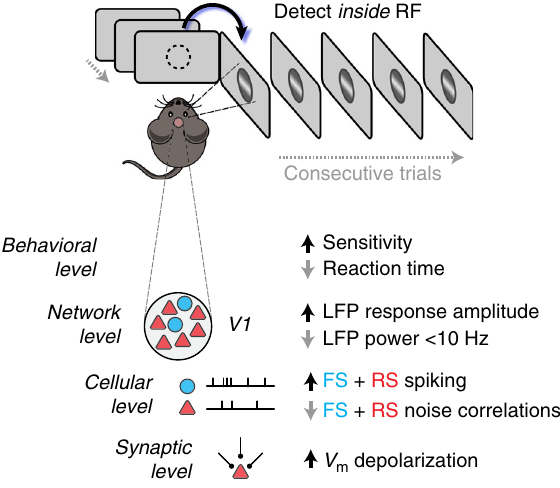
Fig. 8 Summary of observed effects consistent with spatial attention. At the behavioral level, detection speed and sensitivity improved. At the network level, LFP responses increased and <10 Hz power decreased. At the cellular level, RS and FS responses increased while noise correlations decreased. At the synaptic level, V m depolarized and V m fl uctuations increased.